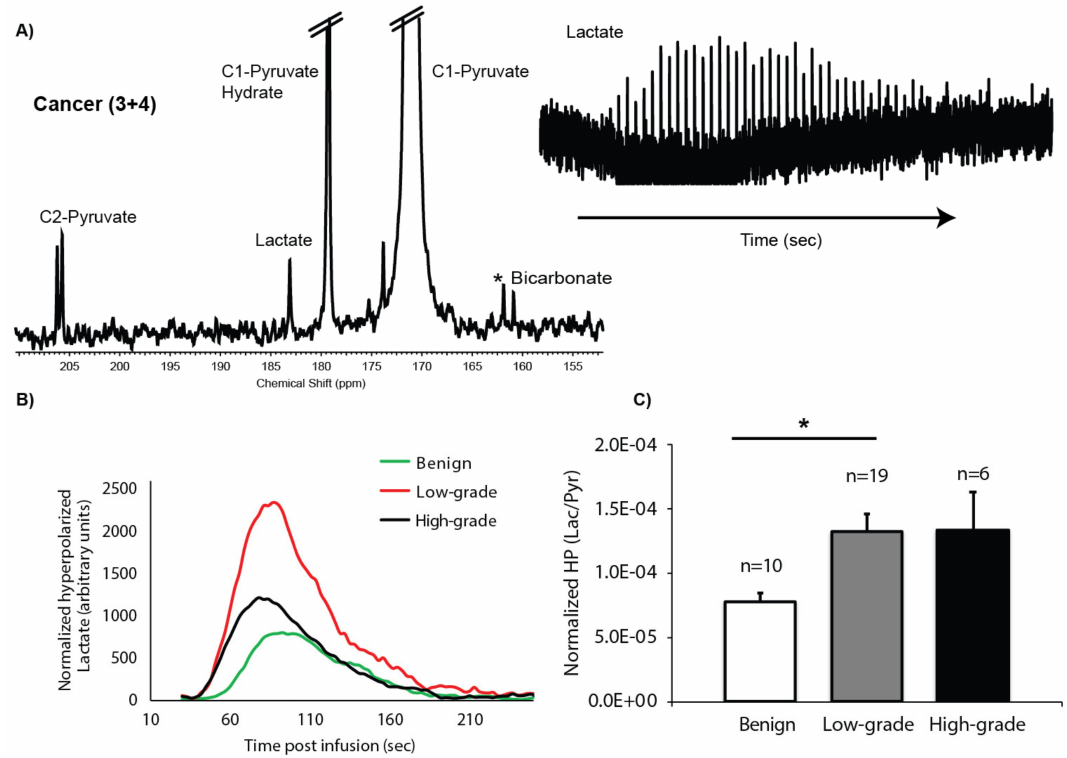
Figure 3. Hyperpolarized (HP) 13 C spectroscopy of TSCs. ( A ) Representative summed 13 C spectrum from a TSC containing 44% cancer of Gleason score 3 + 4 post-injection of HP [1- 13 C]pyruvate (left) as well as the dynamic time course of the HP [1- 13 C]lactate signal (right); ( B ) Representative HP lactate kinetics from each type of TSC (benign, low-grade cancer, or high-grade cancer), normalized to the ff erence β NTP peak; ( C ) Bar graph of normalized ratios of AUC Lac / Pyr demonstrates a significant di only between the benign and low-grade cancer TSCs (* indicates p <